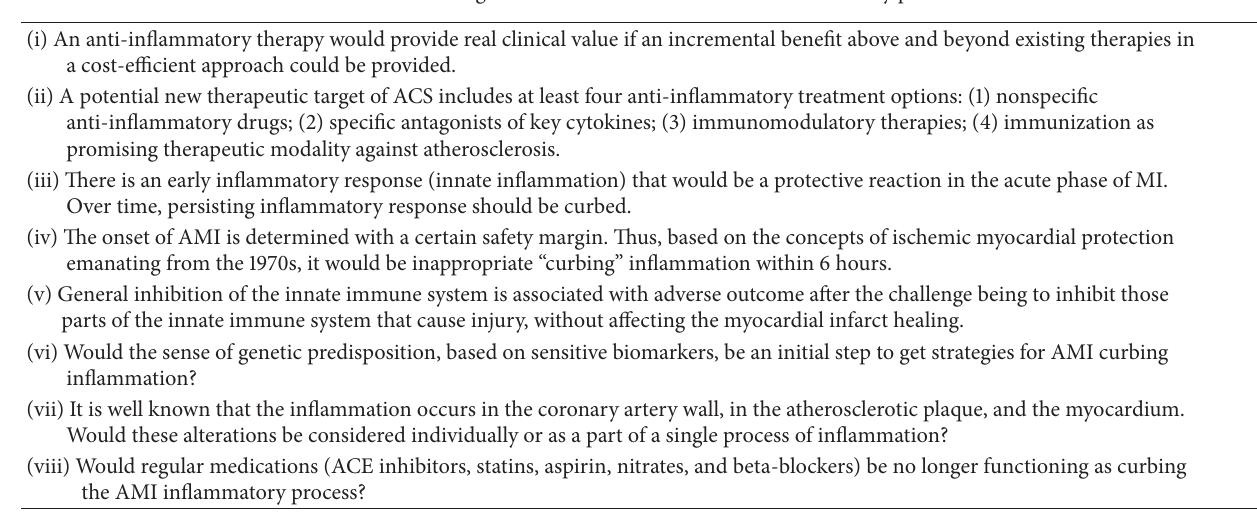
Table 2: Curbing inflammation in ischemic heart disease—key